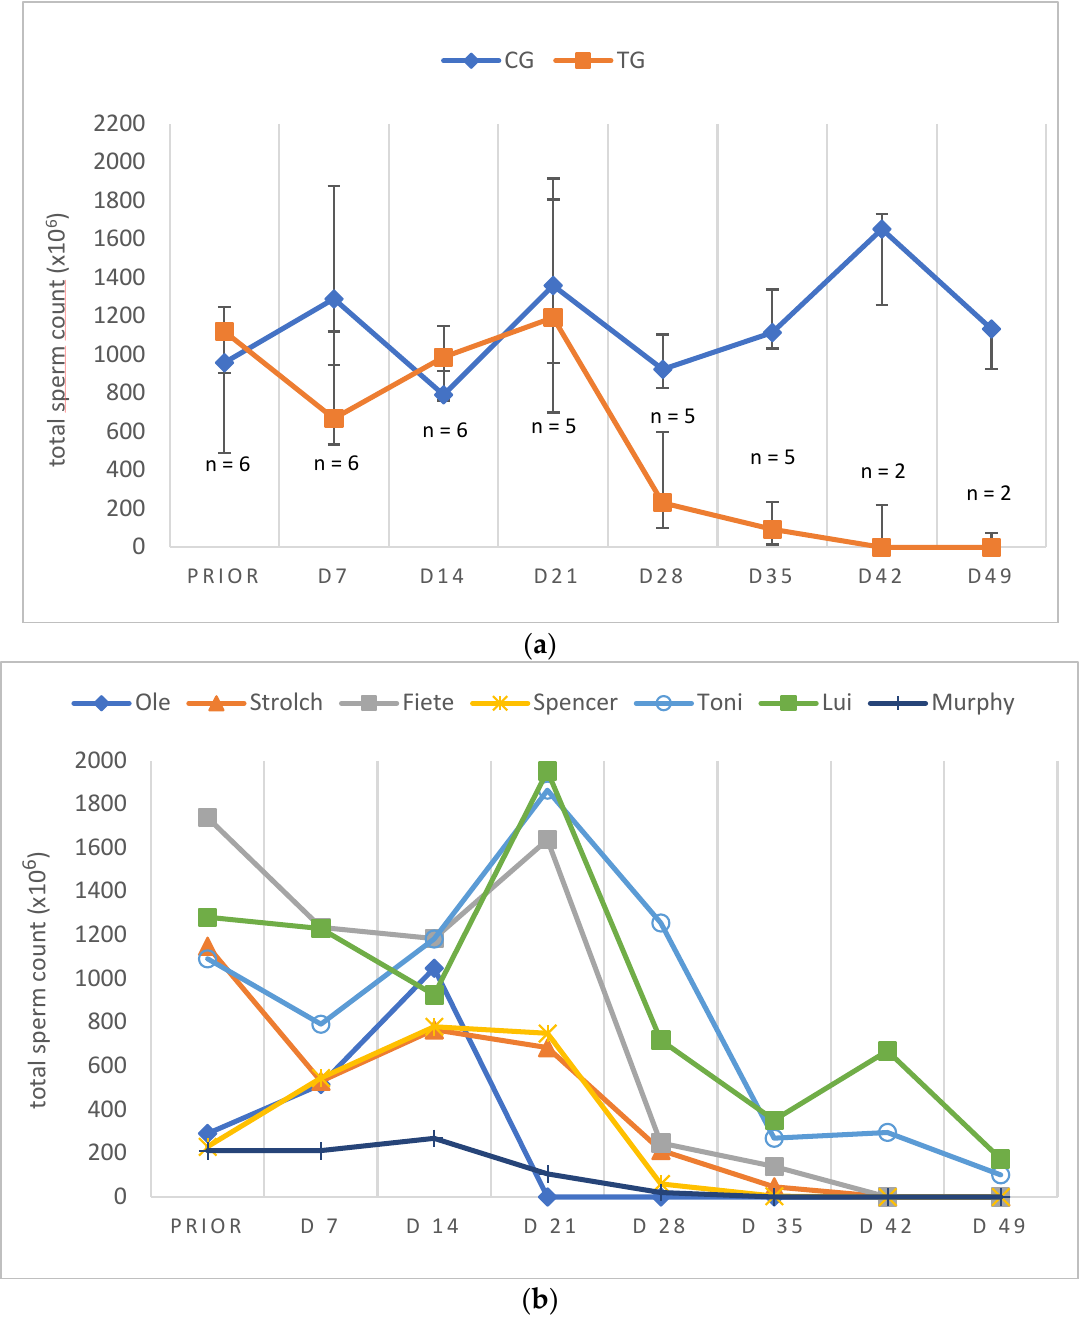
Figure 8. ( a ) Total sperm count (×10 6 ) over time given as median (Q1, Q3) of animals treated with a 4.7 mg deslorelin implant (TG = 6, if not indicated otherwise) and saline-treated control animals (CG, n = 3). “Prior” indicates “prior to treatment”. ( b ) Total sperm count (×10 6 ) given as individual courses of animals treated with a 4.7 mg deslorelin implant (TG, n = 7). “Prior” indicates “prior to treatment”.